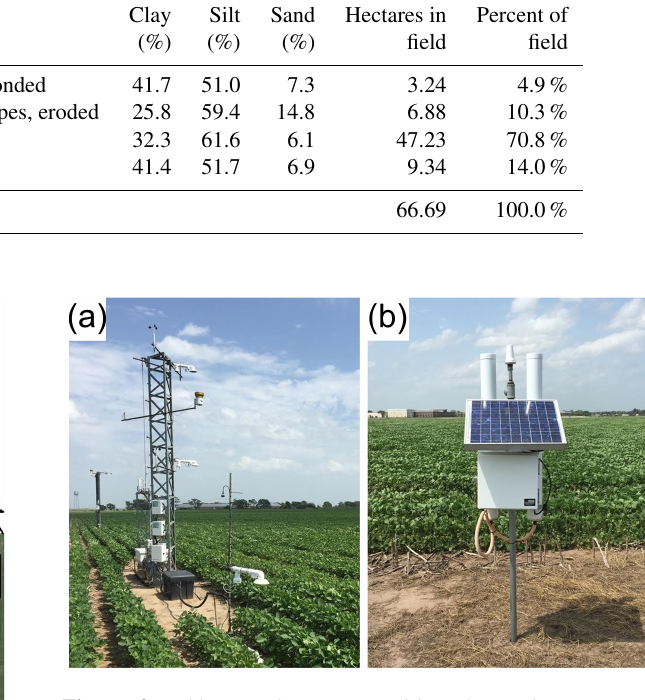
Figure 2. Eddy covariance tower (a) and cosmic-ray neutron probe (b) located at the Mead rain-fed (US-Ne3)